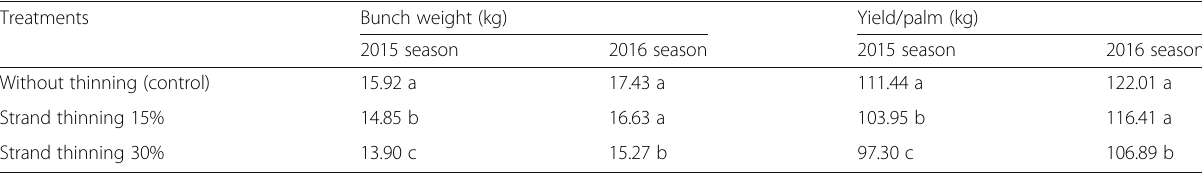
Table 1 Effect of strand thinning treatments on average bunch weight (kg) and yield/palm (kg) of Khadrawi date palm cultivar at rutab stage during 2015 and 2016 seasons Treatments Bunch weight (kg)